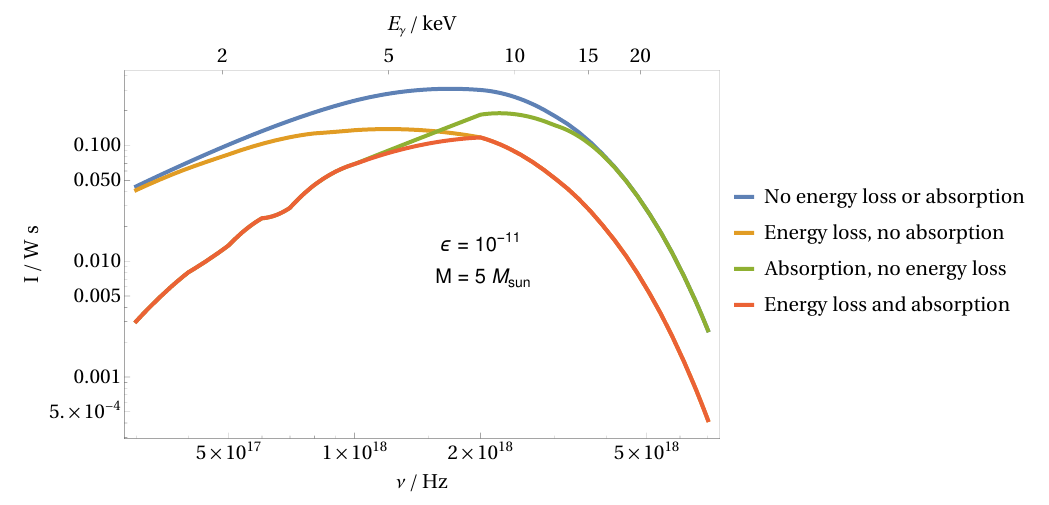
Figure 5 . Modi(cid:12)cations to original X-ray emission spectrum due to energy loss via Thomson scattering and X-ray absorption. Absorption e(cid:11)ects due to free-free absorption are stronger at lower